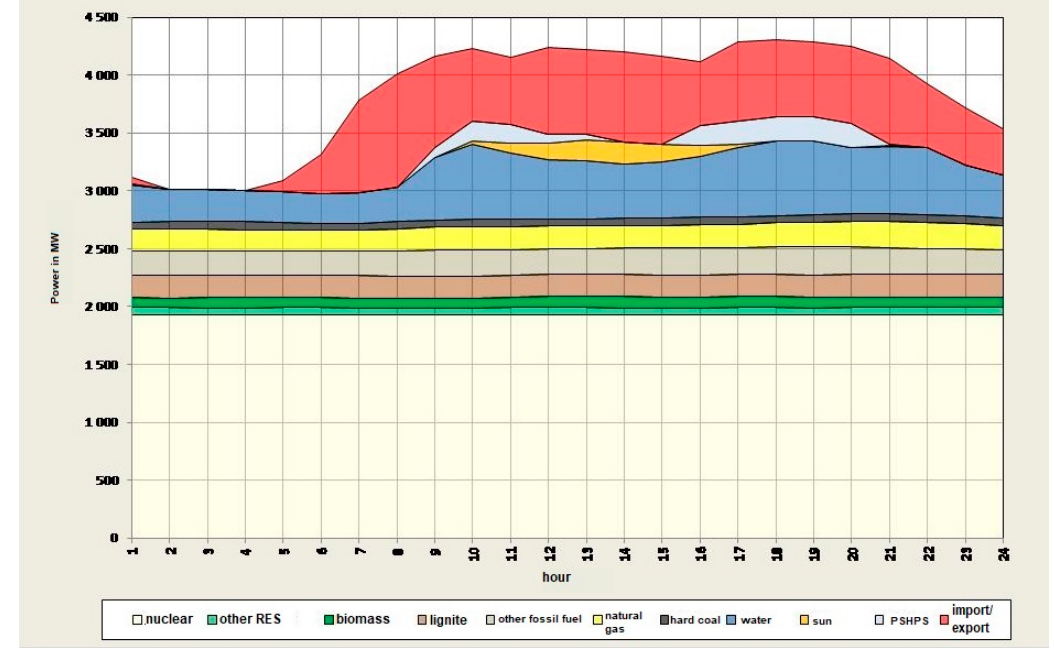
Figure 8. Slovak electrical system utilization and its coverage by the energy sources on 7.12.2018 (Source: [35]). PSHPS—Pumped-storage hydropower stations.